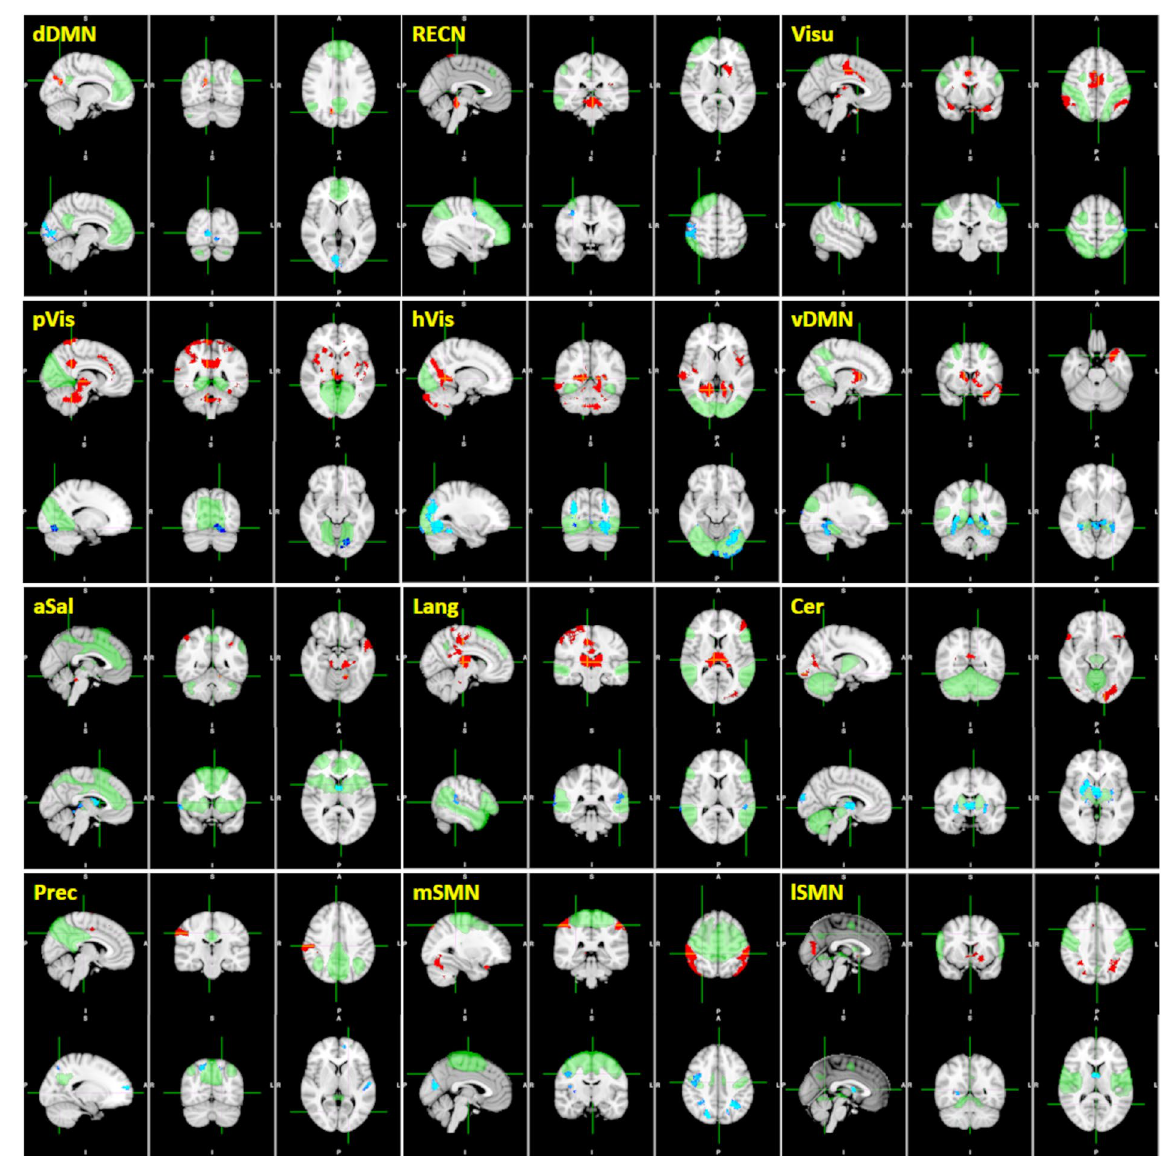
Figure 2. Cross sectional increases and decreases in functional connectivity within and outside canonical resting state networks (RSN) with age. Green regions indicate RSN (group IC thresholded at z > 3.0 for display), blue for negative correlation with age, and red for positive correlation with age. dDMN – dorsal default mode network; RECN – right executive control network; Visu – visuospatial network; pVis – primary visual network; hVis – high visual network; vDMN – ventral default mode network; aSal – anterior salience network; Lang – language network; Cer – cerebellum; Prec – precuneus network; mSMN – medial sensorimotor network; lSMN – lateral sensorimotor